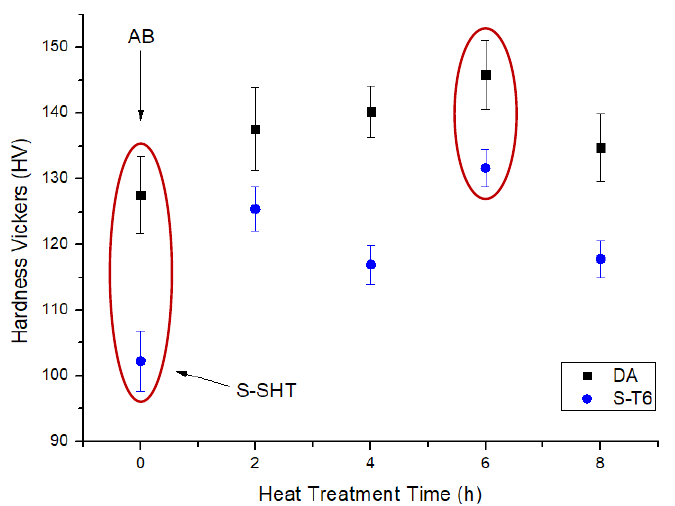
Figure 3. Hardness trends during DA and S-T6 aging at 170 °C. The red circles highlight the selected heat treatments.